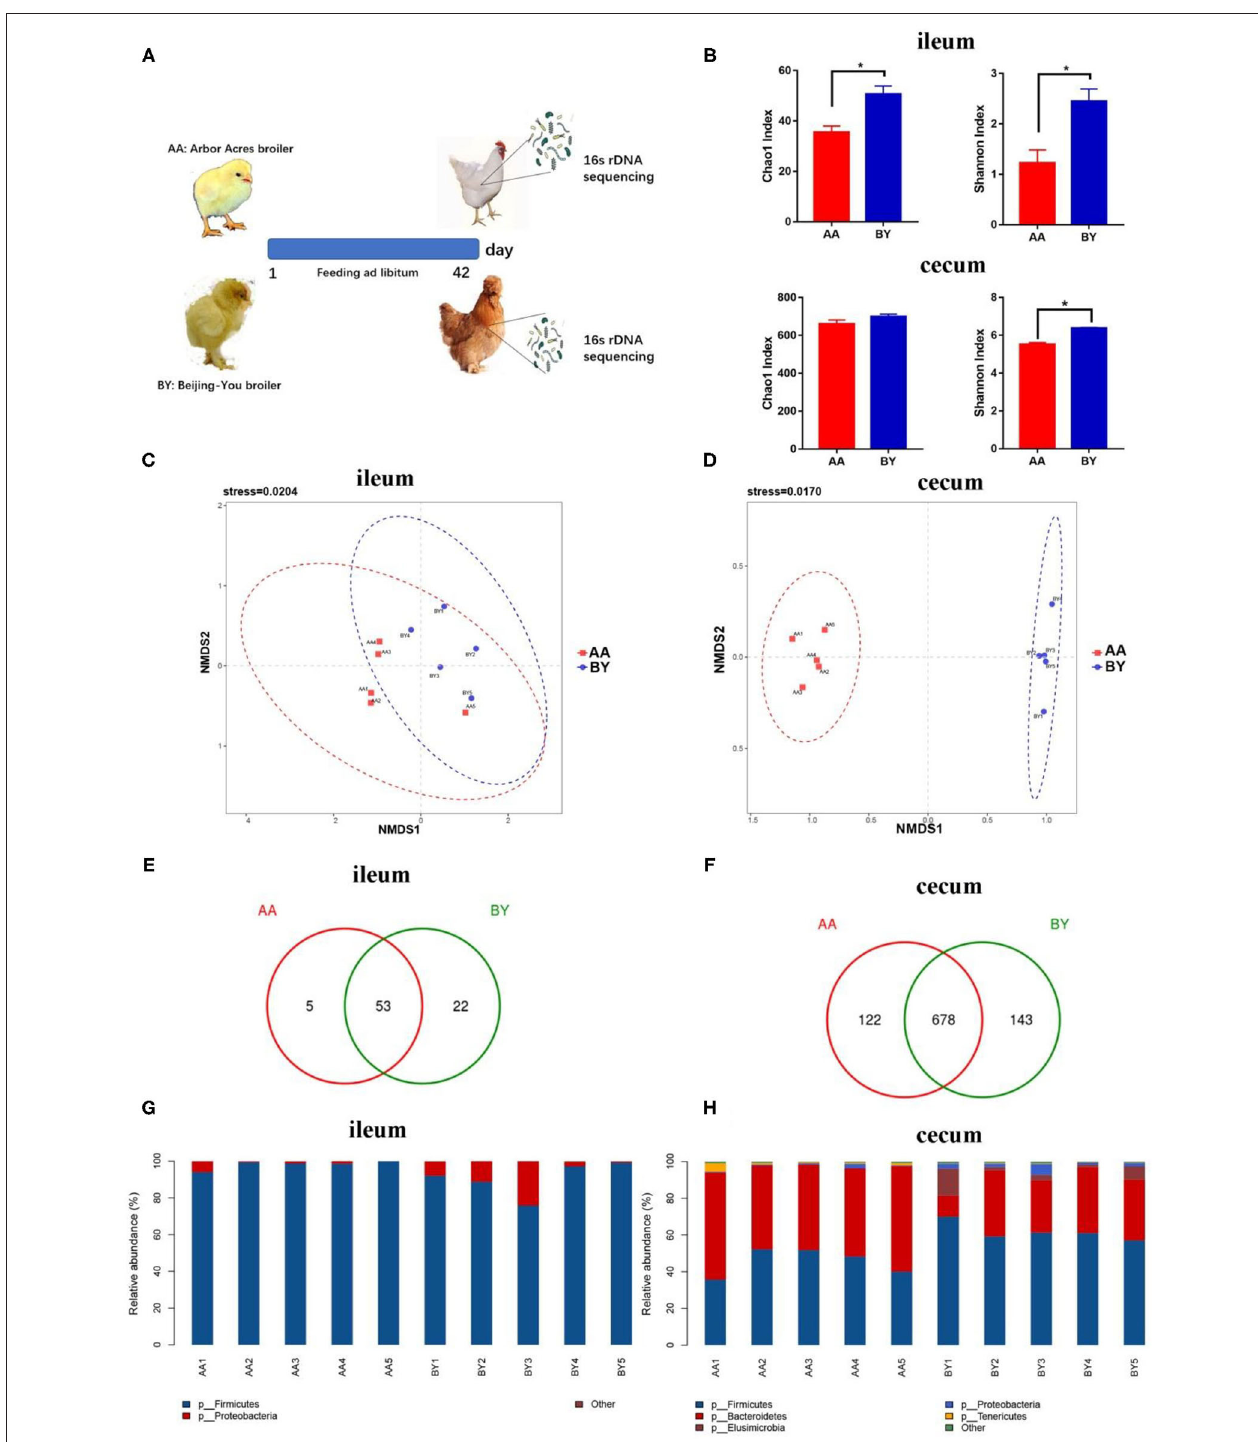
FIGURE 1 | Intestinal microbiota structure of the Arbor Acres broilers and the Beijing-You broilers. (A) Graph of microbiota composition. (B) Alpha diversity analysis of the Chao1 index and the Shannon index. (C,D) Scatterplot from nonmetric multidimensional scaling (NMDS) in bacterial composition. (E,F) Venn diagram of unique operational taxonomic units (OTUs) in ileum and cecum. (G,H) Microbiota structure at the phylum level in ileum and cecum. AA: the Arbor Acres broilers; BY: the Beijing-You broilers. The numbers of independent biological samples analyzed in panel B to H were AA ( n = 5) and BY ( n = 5). Data in (B) are expressed as mean ± SEM. Data in (B) were analyzed using ANOVA followed by the Tukey’s test and were considered as statistically significant at * p < 0.05 between the indicated groups. Data in (C,D) were analyzed using nonmetric multidimensional scaling. Data in (C–H) statistical tests were two-sided and differences were considered to be statistically significant at p <